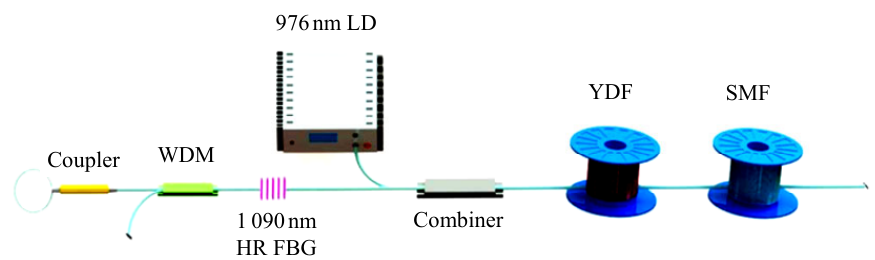
Fig. 39 Experimental setup of the high-order RFL pumped by the YRFL.